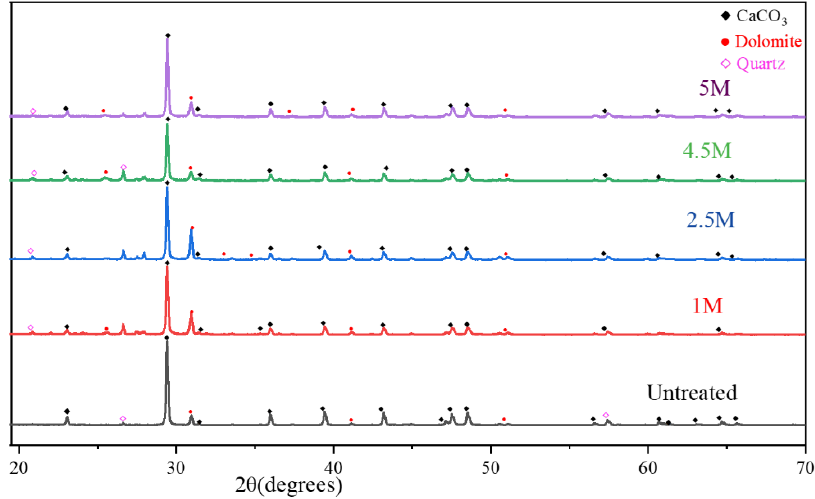
Figure 3. XRD pattern of samples treated with H 2 SO 4 /untreated.